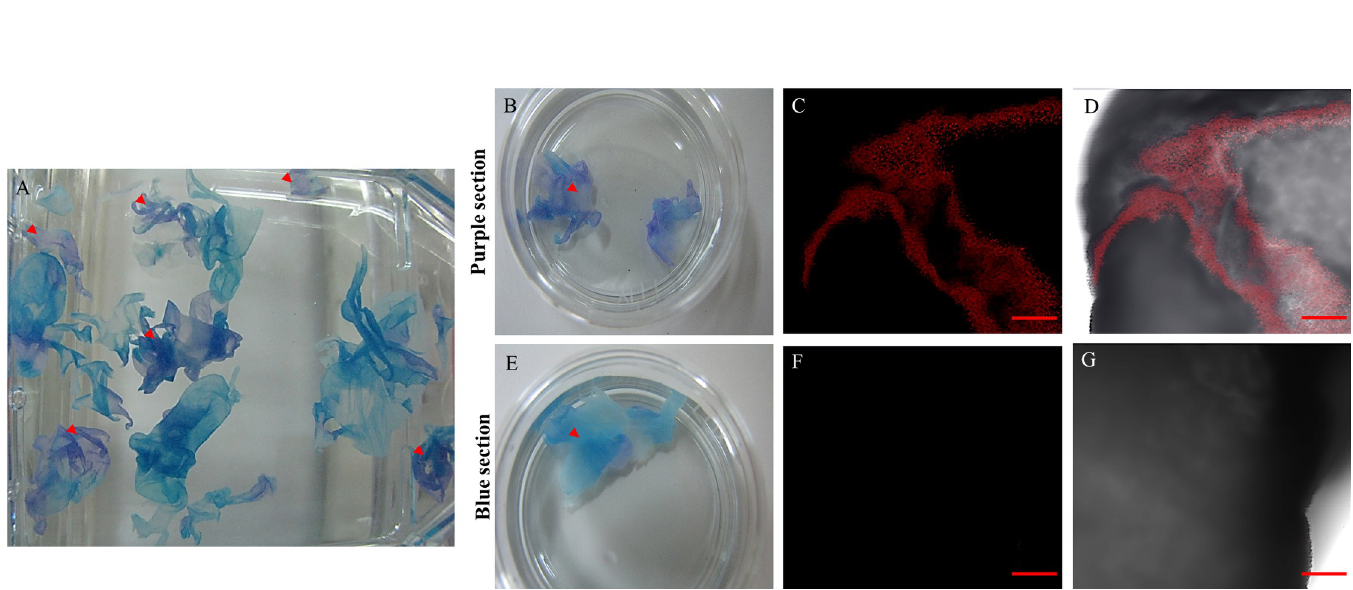
Fig 2. Racemose larvae sample after double staining. Macroscopic view of the sample (A), purple (arrowheads) and blue sections were placed in separate Petri dishes for confocal microscopy. The purple sections and blue sections in petri dishes (B,E) and 20X confocal pictures were taken, red for mitotracker (C,F) and merge with brightfield (D,G). In all the purple sections a positive signal for the mitotracker was observed. After 48 hours, the staining was repeated and the same results were obtained. Scale bar: 200 μ m.